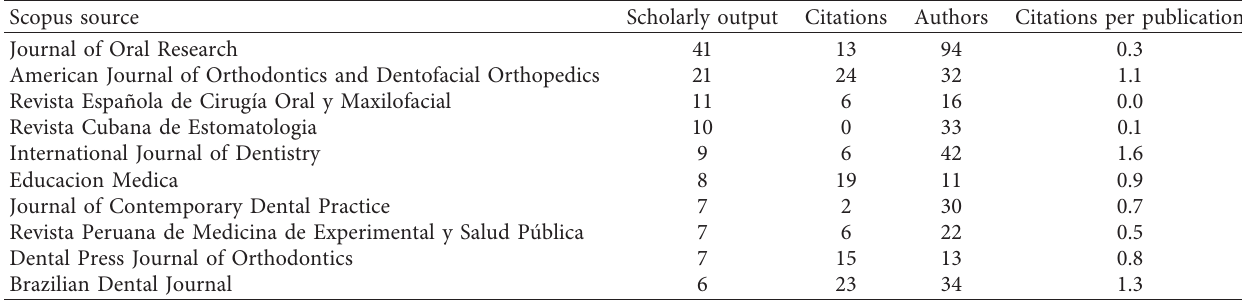
Table 2: Scholarly output by Scopus Source (2014–2019) of all public and private Peruvian Faculties of Dentistry. Scopus source